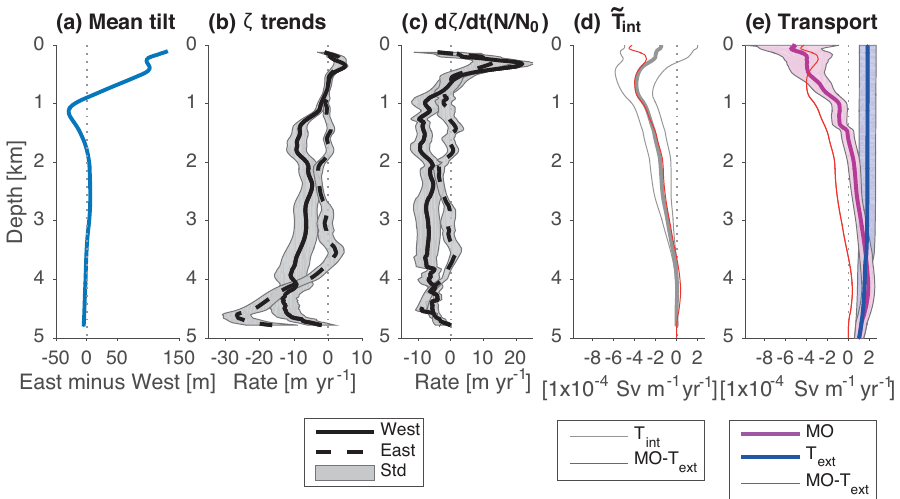
Figure 12. Trend in isopycnal displacements and transports. (a) Mean height difference between isopycnals in the east and west. (b) Trend in isopycnal displacements at the western and eastern boundaries, where a negative (positive) trend indicates downward (upward) movement of isopycnals. The solid (dashed) line is for displacements at the west (east). (c) Trend in displacements scaled by buoyancy frequency with N 0 = 1 × 10 − 3 s − 1 . (d) Trend in e T int from Eq. (2). The red line is the trend in MO (z) − T ext . (e) Trends in transport per unit depth of mid- ocean (MO (z) ) in magenta, T ext in blue. All time series were twice monthly. Confidence intervals on the trends are shaded. The dotted line shows a zero